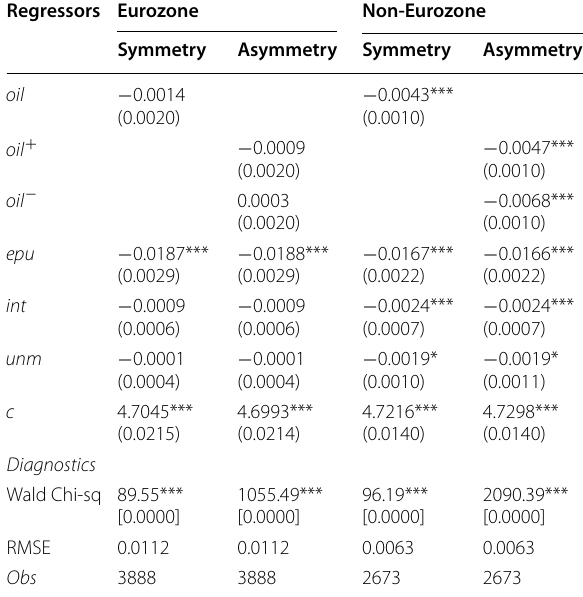
Values in brackets are standard errors, while those in parentheses are probabilities. *** and * indicate significance at 1% and 10% critical levels,